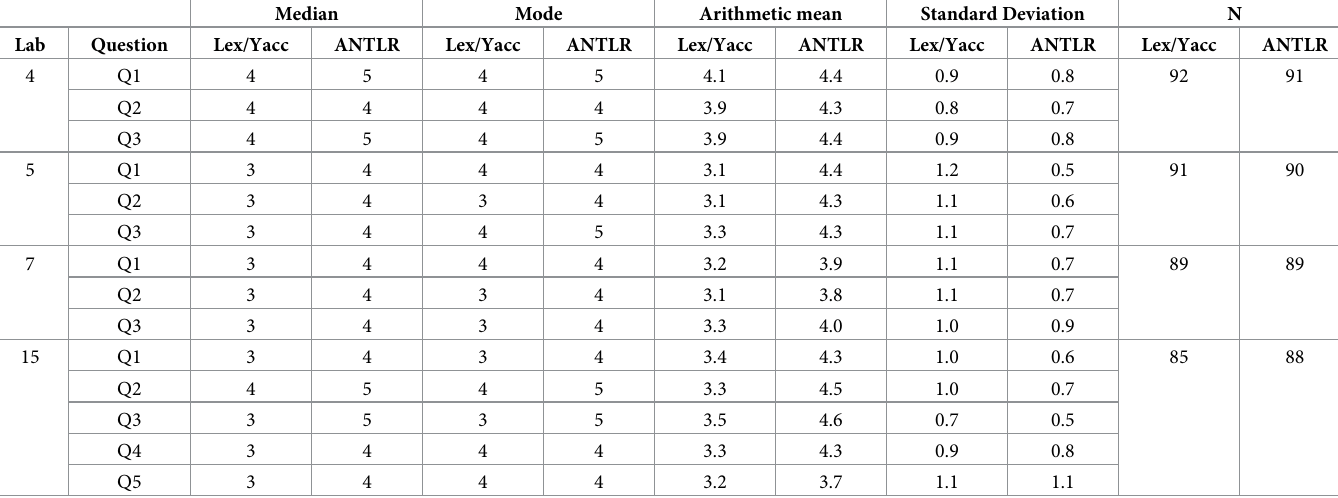
Table 7. Median, mode, arithmetic mean, standard deviation, and size (N) of the Likert scale answers to the questionnaire in Table 4. Median Mode Arithmetic mean Standard